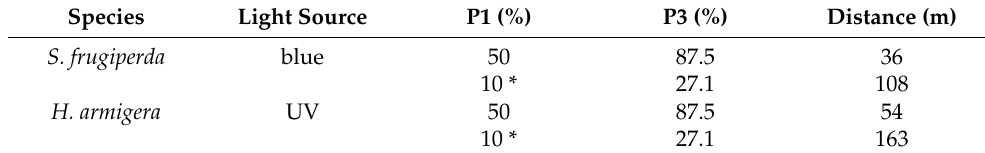
Table 1. Phototactic rates and trapping distances of two moths to different lights. Species Light Source P1 (%) P3